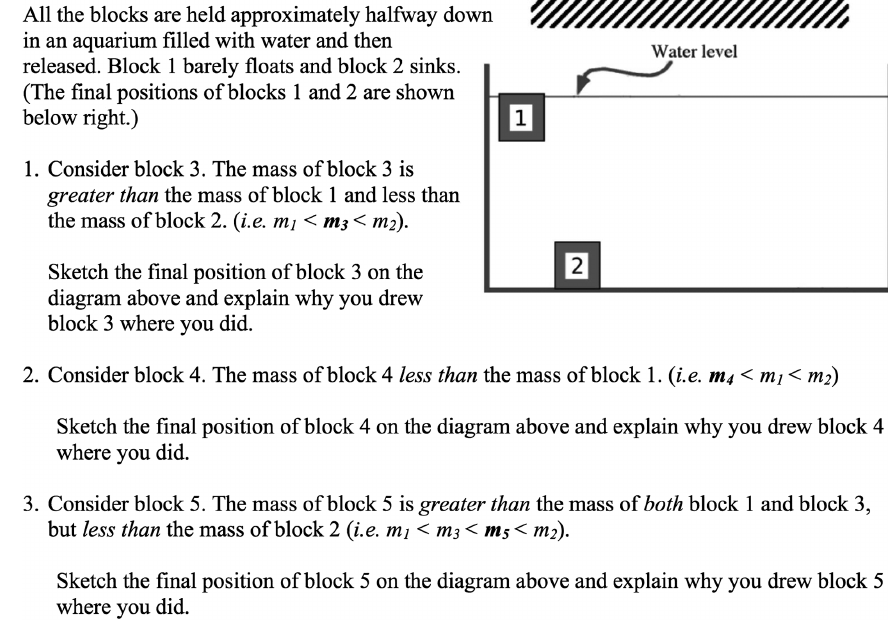
density.FIG. 5. The modified version of the 5-block problem in experiment 2.1: Removing salient distracting